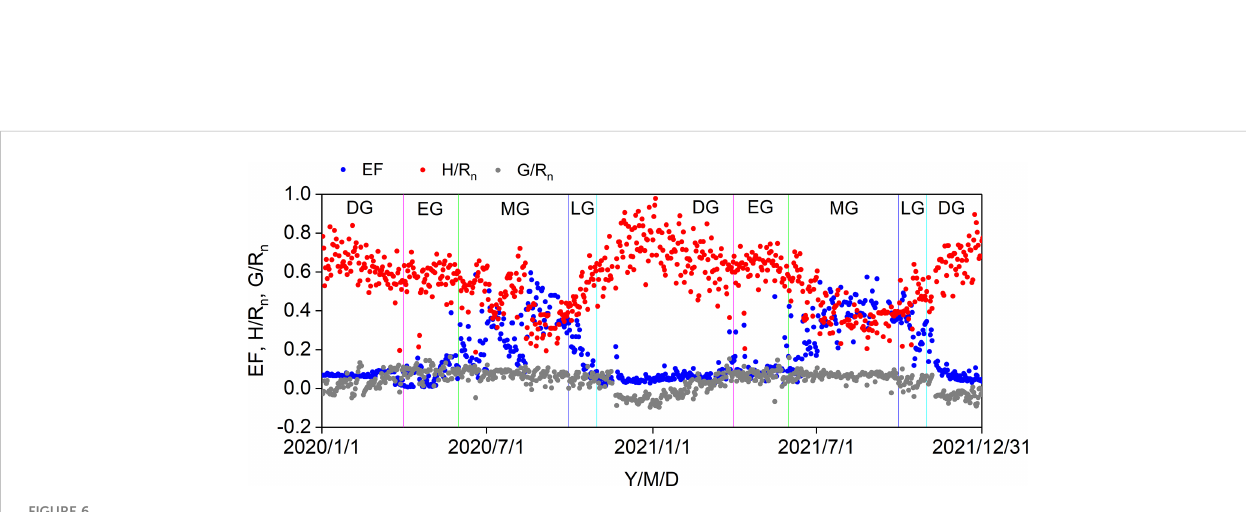
FIGURE 6 Seasonal variations in midday EF, H/R n , and G/R n in 2020 and 2021. DS: dormant season, EG: early growing stage, MG: mid growing stage, LG: later growing stage.